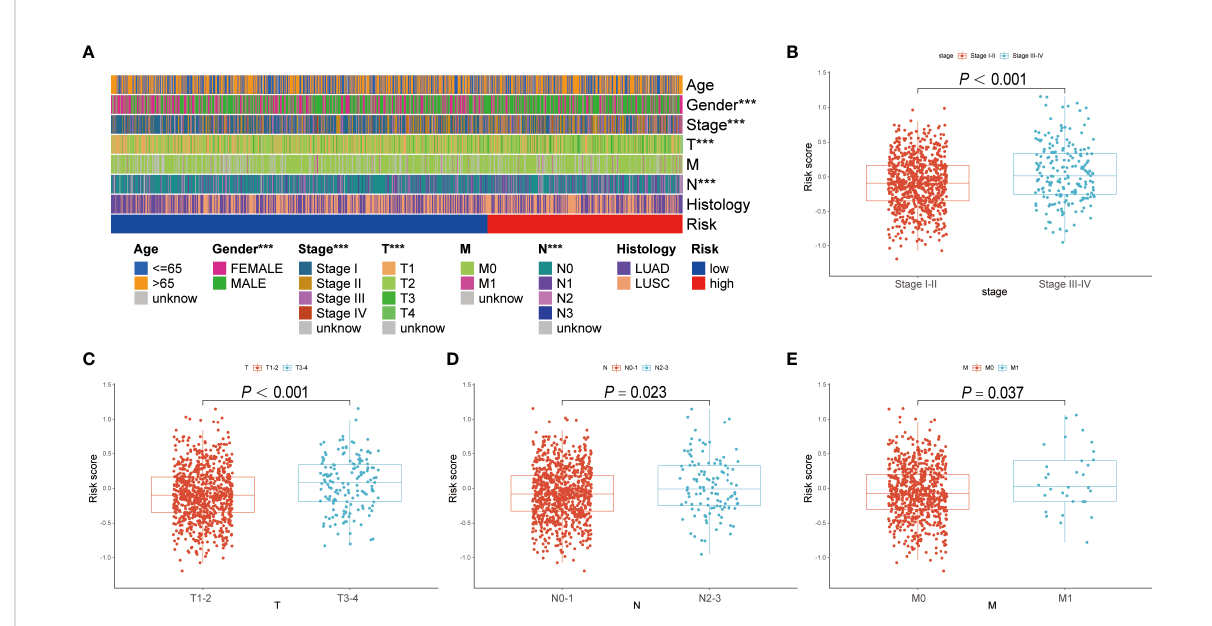
FIGURE 4 Correlation analysis between BRGPs signature and clinicopathological characteristics of NSCLC patients. (A) Heatmap reveals that patient ’ s gender (P<0.001), T stage (P<0.001) and N stage (P<0.001) are signi fi cantly related to BRGPs signature based on the chi-square test. (B-E) Box plot reveals that the risk scores of NSCLC patients are signi fi cantly related to the clinical stage (B) , T stage (C) , N stage (D) , and M stage (E) based on Wilcoxon rank-sum test. BRGPs, B cell-related gene pairs; NSCLC, non-small cell lung cancer. ***P < 0.001.